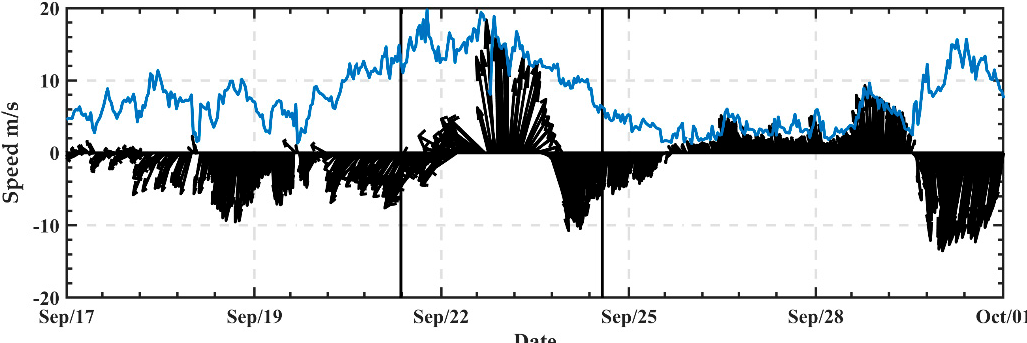
Figure 11. Measured wind data at Changjiangkou station in September 2014, where the period of Typhoon Phoenix is indicated by two vertical lines.